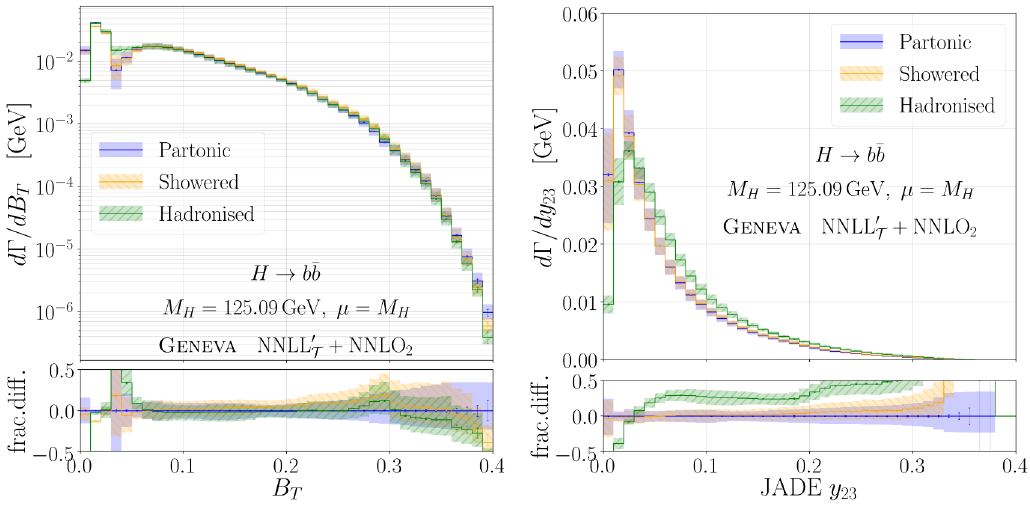
Figure 9. Jet broadening and the JADE two-to-three differential jet rate at the partonic, showered and hadronised levels for H ! b (cid:22) b .